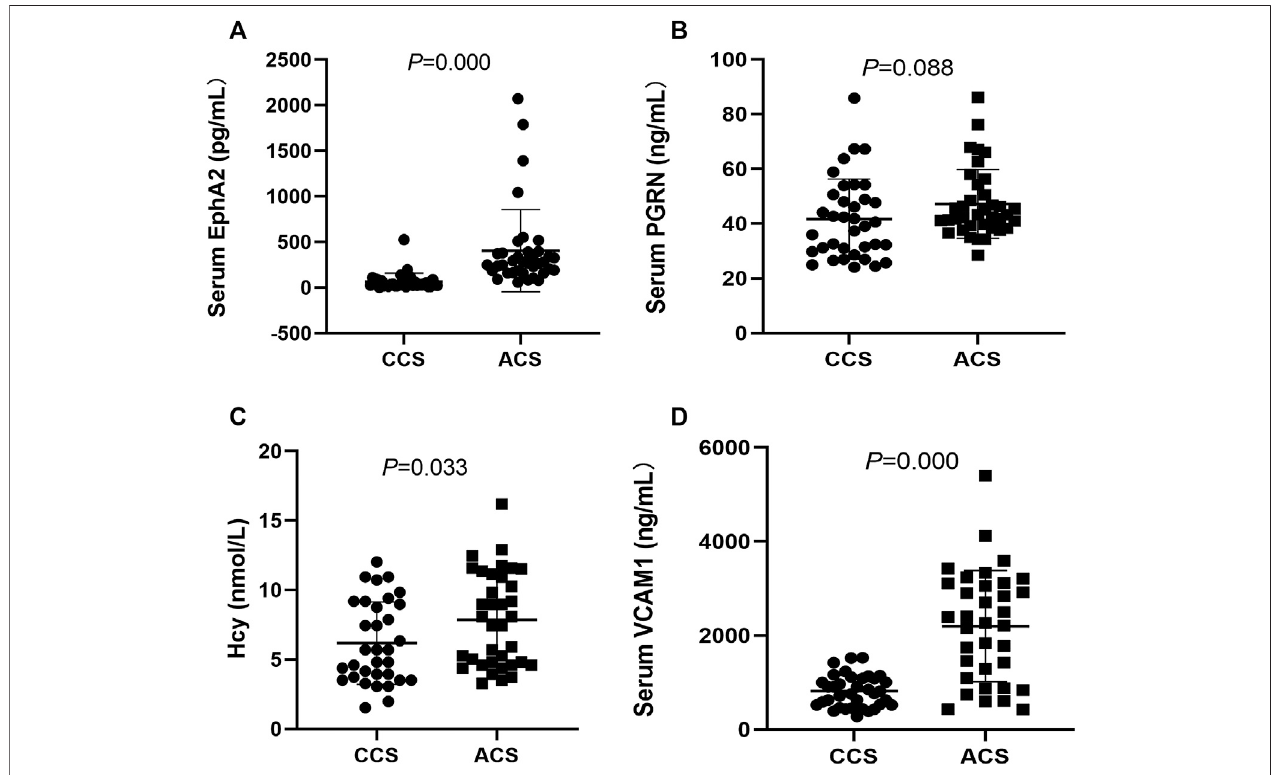
FIGURE 1 | Comparison and correlation analysis of clinical indexes between the CCS patients (n (cid:1) 36) and the ACS patients (n (cid:1) 37). (A – D) Comparison of serum levels of EphA2, PGRN, VCAM1 and Hcy, respectively. CCS: chronic coronary syndrome; ACS: acute coronary syndrome. EphA2: Eph-receptor tyrosine kinase-type A2, PGRN: Progranulin, VCAM1: vascular cell adhesion molecule-1; Hcy: